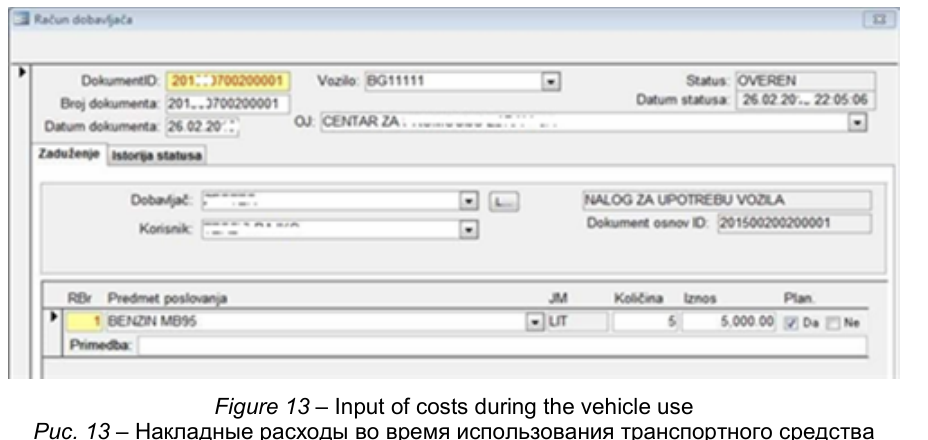
Figure 13 – Input of costs during the vehicle use Рис . 13 – Накладные расходы во время использования транспортного средства Slika 13 – Unos troškova tokom upotrebe vozila Costs for each vehicle in the fleet are entered into this